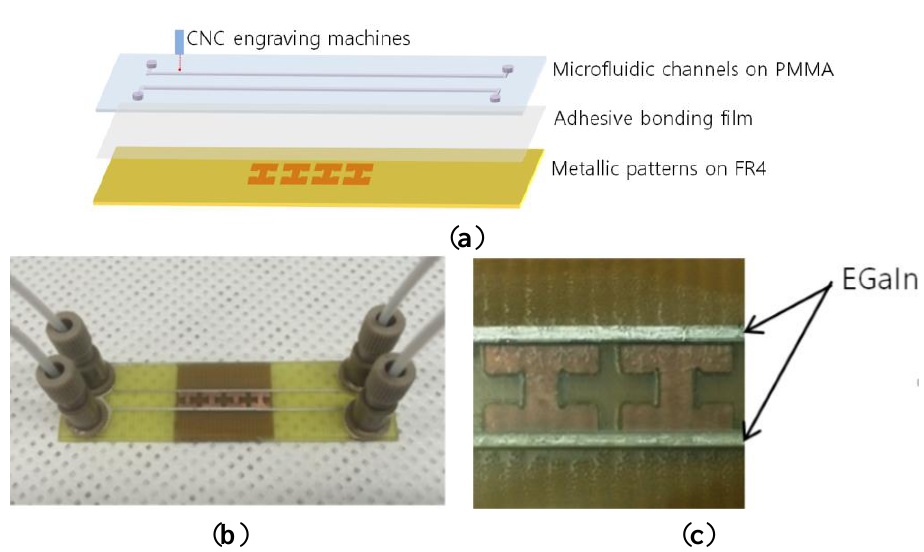
Figure 6. ( a ) Illustration of three layers of proposed microfluidic metamaterial absorber; ( b ) Fabricated absorber sample; ( c ) Zoom-in sample with liquid metal-filled channels.